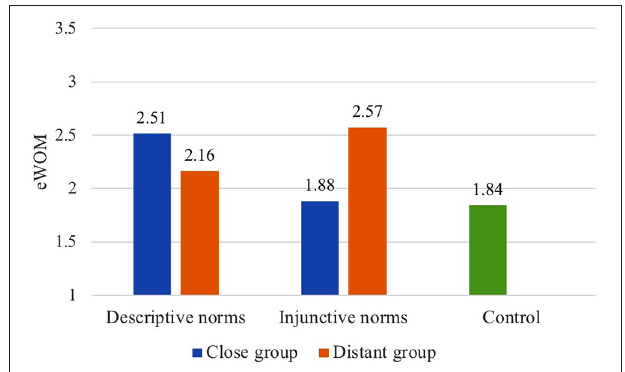
FIGURE 2 | The interaction of group distance and norms type on eWOM (Study